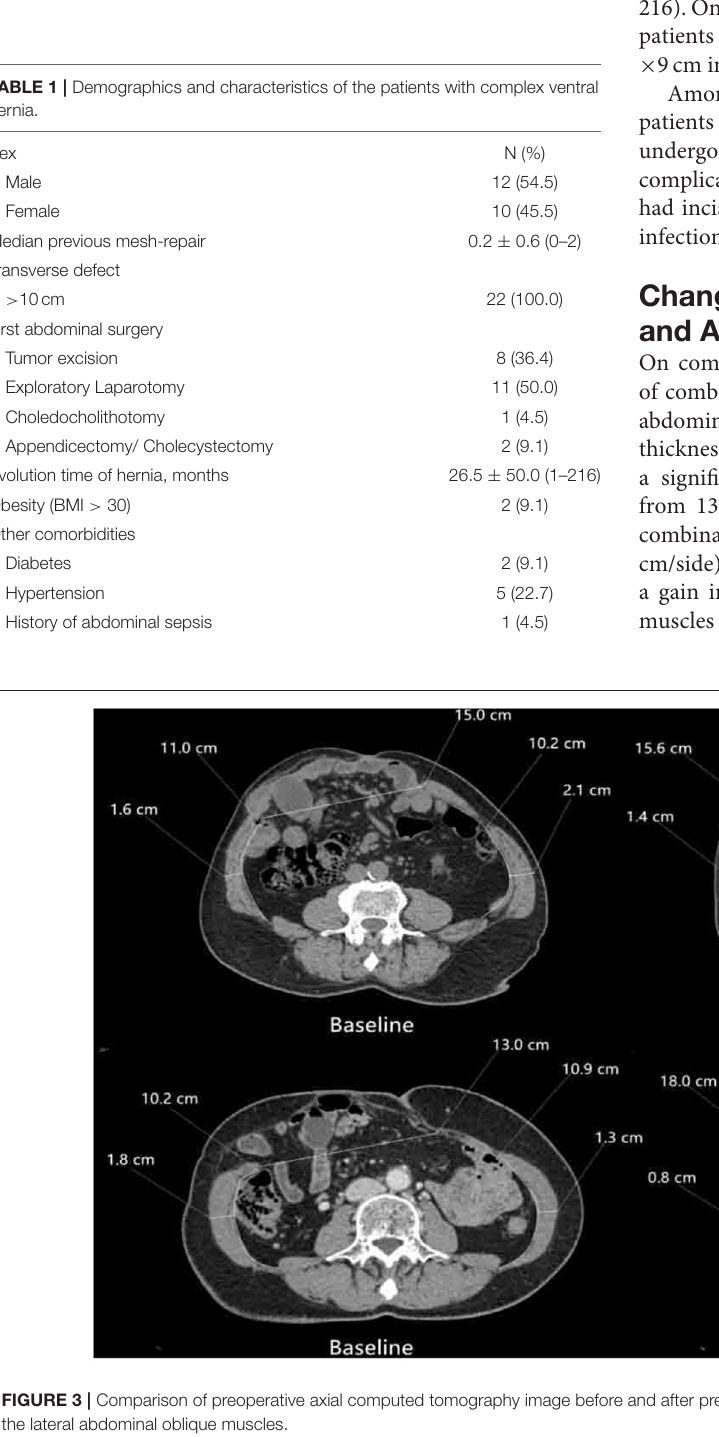
Frontiers in Surgery |